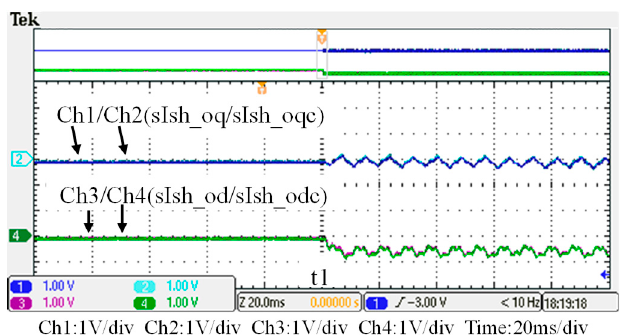
controller output signal (t 0 –t 2 ).